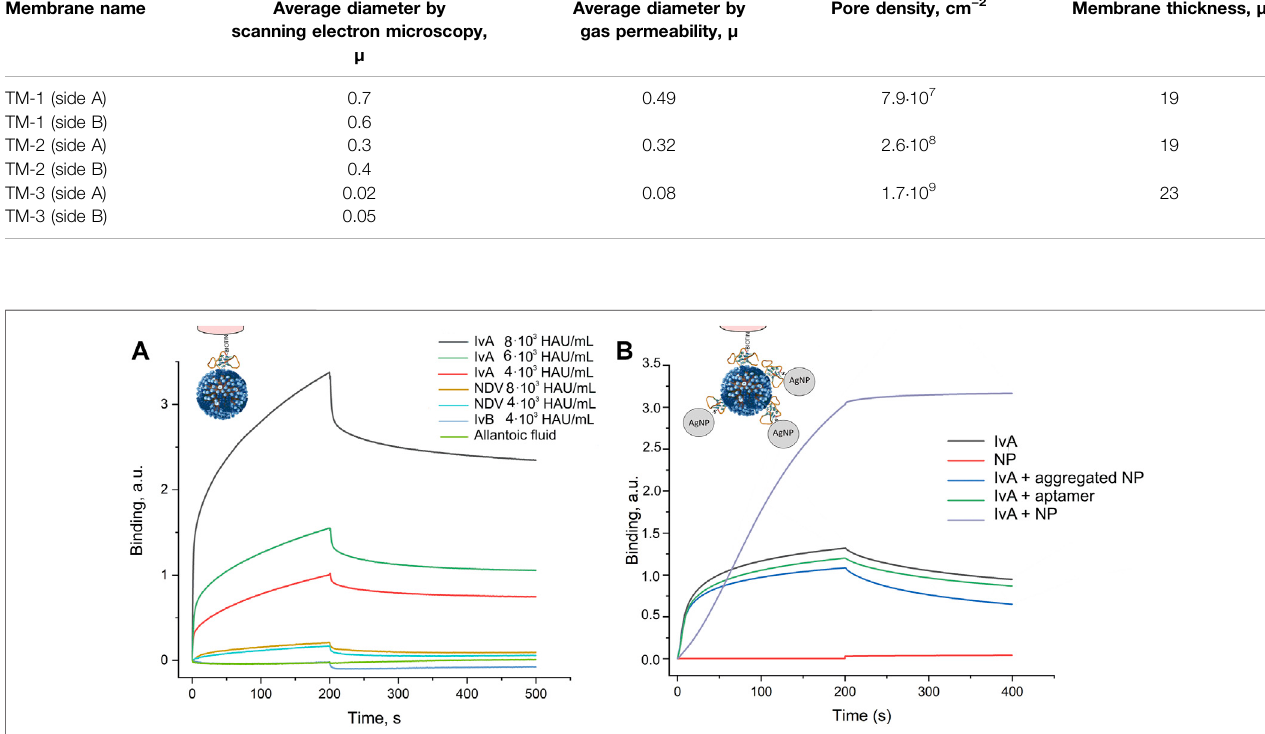
FIGURE1 | Interactionbetween theaptamer and virusesassessed bybiolayer interferometry. (A) Speci fi city ofthe aptamer RHA0385 toward thein fl uenza A virus (IvA)comparedtotheNewcastlediseasevirus(NDV),in fl uenzaBvirus(IvB),orvirus-freeallantoic fl uid.TheexperimentswereperformedinthebufferwithTween-20and bovine serum albumin to eliminate non-speci fi c interactions. (B) Visualization of an assembly of sandwich-like complexes in the buffer without Tween-20 and bovine serumalbumin.Theaptamer-functionalizedsensorinteractswith1)4 · 10 3 HAU/mlofIvA;2)aptamer-functionalizedsilvernanoparticles;3)4 · 10 3 HAU/mlofIvAwith aggregatedaptamer-functionalized silvernanoparticles;4)4 · 10 3 HAU/ml ofIvAwithasolubleaptamer;and 5) fi rst, with4 · 10 3 HAU/mlofIvAandsecond,withaptamer- functionalized silver